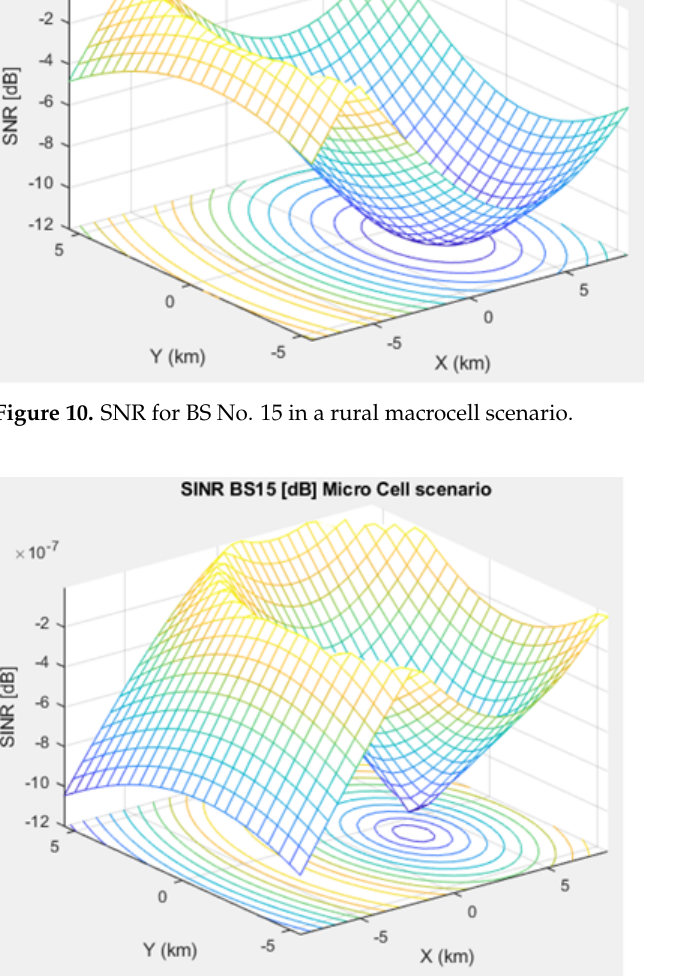
Figure 11. Signal Interference to Noise Ratio for BS No. 15 in a microcell scenario.